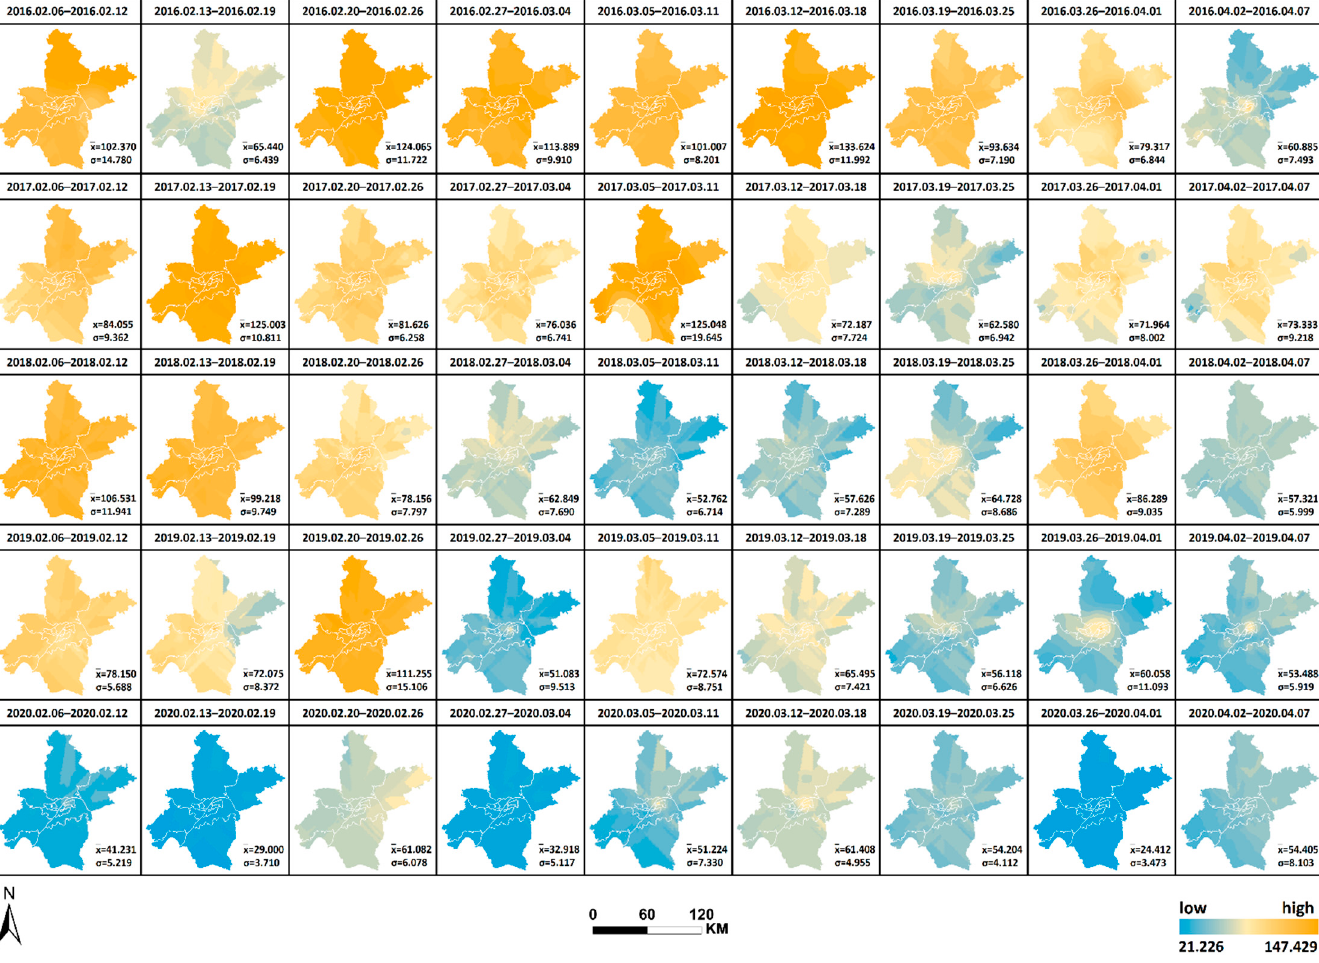
Figure 13. PM 2.5 matter interpolation chart from 2016 to 2020.